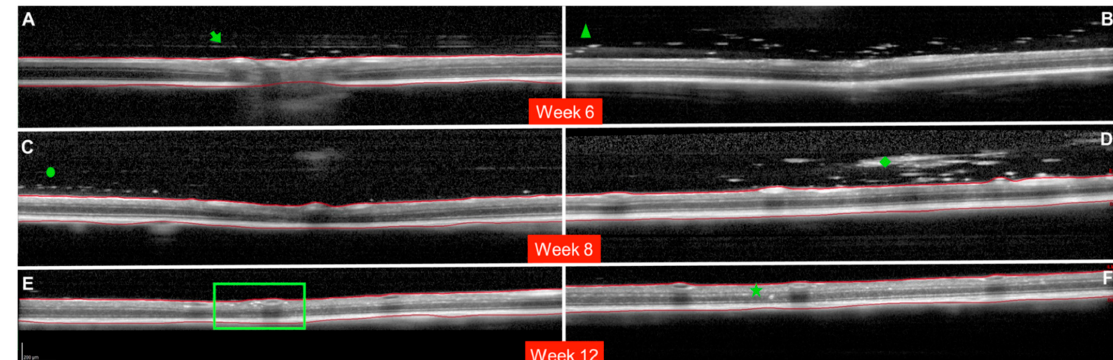
Figure 2. Milestones in the evolution of the brimonidine–Laponite intravitreal formulation (BRI/LAP IF) analysed using optical coherence tomography. ( A ): Cross-sectional image of the optic nerve showing hyper-reflective IF aggregates after crossing the posterior vitreous cortex (PVC). The green arrow points to the posterior vitreous cortex. Three hyper-reflective dots are found in the space between the PVC and the inner limiting membrane (ILM). ( B ): Hyper-reflective aggregates (green triangle) at the moment of crossing the posterior vitreous cortex. ( C ): Hyper-reflective aggregates (green circle) arranged one-by-one in a row. ( D ): Large BRI/LAP IF aggregate (green rhombus) in the vitreous humour. A light optical shadow can be observed (indicating potential perception of floaters) similar to the shadow that retinal vessels produce. ( E , F ): Hyper-reflective aggregates penetrating the retinal layers. Deposits in the inner nuclear layer or perivascular (green square). Deposits in the outer nuclear layer (green star). Red lines indicate the ILM and retinal pigment epithelium (RPE) boundaries. ( B ) Shows an example without boundaries (red lines) so as to permit measurement. ( A , B ) Show images obtained at 6 weeks of follow-up. ( C , D ) Show images obtained at 8 weeks of follow-up. ( E , F ) Show images obtained at 12 weeks of follow-up. Representative images are extracted from different animals.